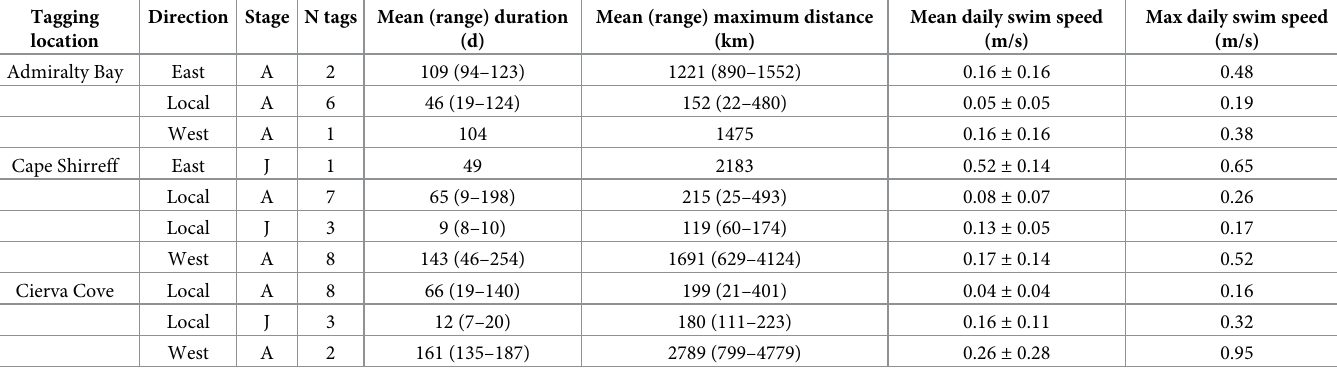
Mean and range of deployment durations, maximum distances reached, and sustained swim speeds for adult (A) and juvenile (J) stages from each tagging location at Admiralty Bay, Cape Shirreff, and Cierva Cove. Swim speed was calculated from the mean of net distances moved per month, weighted by the number of days tracked in each